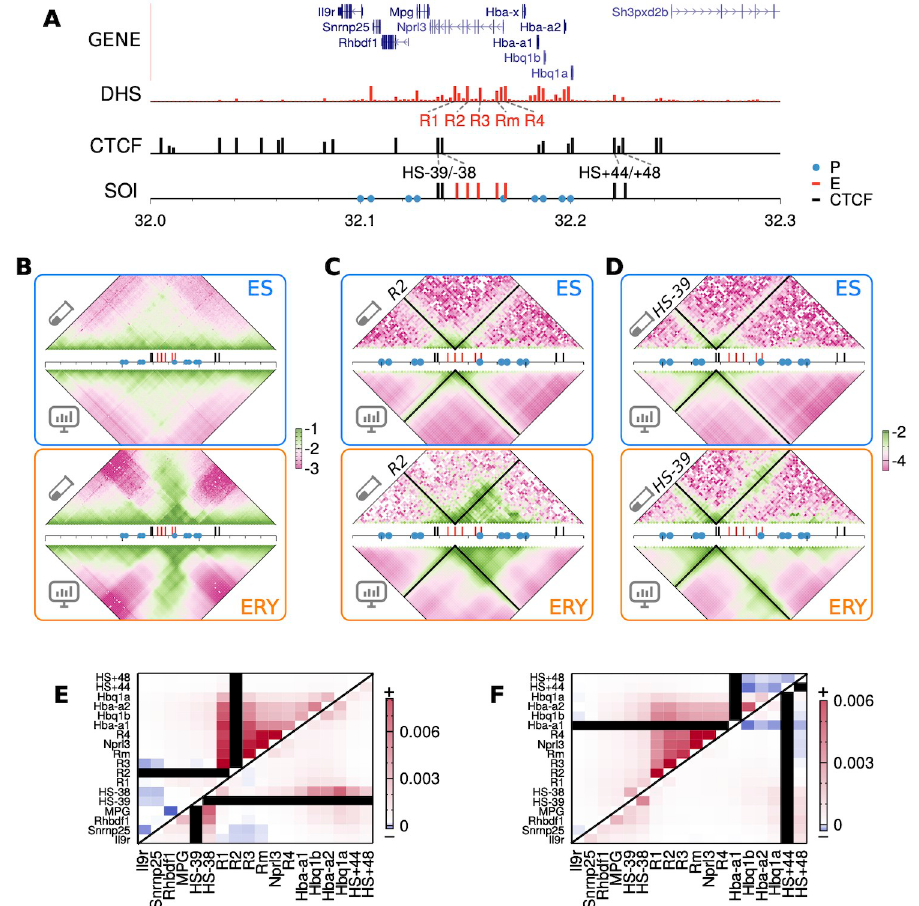
Fig 3. Three-body contacts predicted with HLM versus those from Tri-C. (A) Gene notation, DNase hypersensitive sites, CTCF-binding sites [59, 60] and genomic regions of interest (sites of interest, SOI) at mouse α -globin locus on chr11. (B) log 10 ( p ) from Capture-C (top triangle) and HLM (bottom triangle) at 2-kb resolution. (C, D) log 10 ( p ij from Tri-C (top) and HLM (bottom) at k = R2 and k = HS-39, whose positions are labeled with black strips. The Pearson correlations between Tri-C and HLM are 0.80 (ES) and 0.75 (erythroid) for k = R2, and 0.89 (EC) and 0.85 (erythroid) for k = HS-39. (E) Cell-line difference of the predicted three-body contacts, p Erythroid with respect to the viewpoints R2, HS-39 and (F) Hba-a1, HS+44.